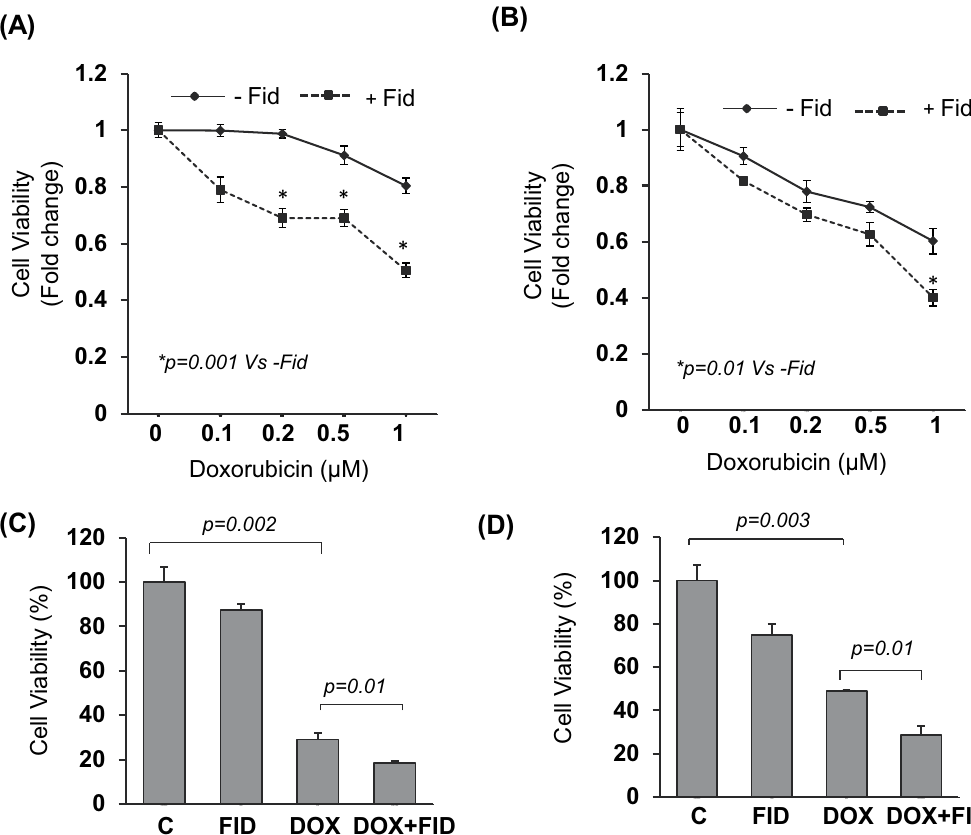
Figure 1. Inhibition of AR enhances the sensitivity of colon cancer cells to DOX: MTT cell viability assay showing the effect of chemotherapeutic drug DOX (0.1–1 μ M) after 72 h of treatment without or with fidarestat (30 µ M) in colon cancer cells ( A ) HT-29 and ( B ) SW480. Cell death was also assessed by Trypan blue cell exclusion assay after 72 h of treatment of ( C ) HT-29 and ( D ) SW480 CRC cells with DOX (1 μ M) without or with fidarestat (30 µ M). Values are Mean ± SD (n = 5). Individual p values are mentioned in the